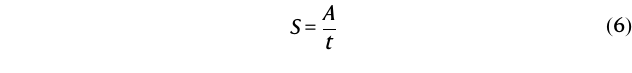
Fig. 4 | Wireless sensor module for full-body motion classi fi cation. a Photos of seven M n sensors attached on the back waist (one M p ), left/right shoulders (two M p-w-p ), left/right elbows (two M w ), and left/right knees (two M w-p-w ) of a volunteer. b Signal outputs, S ε , of a M w-p-w sensor attached on the back waist during repeated stoop motions were too small to be distinguished from noise signals. Signal outputs, S ε , of two M p sensors atta c hed on ( c ) the left shoulder, ( d ) the left elbow, and ( e ) the left knee during repeated movements. Symbol “ ! ” indicates thatthe M p sensors ’ resistances increasedto in fi nite , where M p sensors